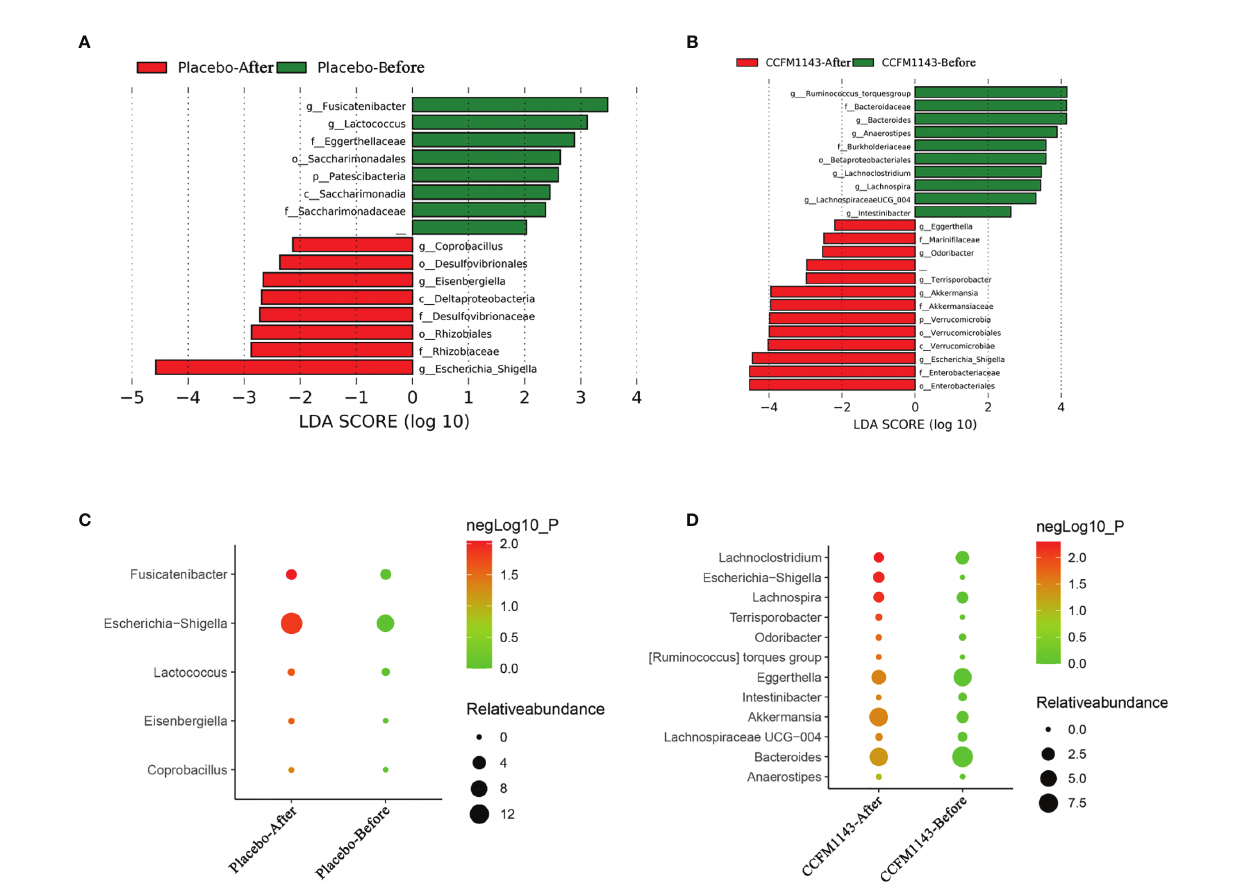
FIGURE 6 | Effect of Lactobacillus plantarum CCFM1143 on the different genera of the gut microbiota in patients with diarrhea. (A) Distribution histogram of the placebo group based on linear discriminant analysis (LDA), with a log LDA score above 2.0. Signi fi cant taxa were labeled and annotated with tags in the right panel . (B) Distribution histogram of the L. plantarum CCFM1143 group based on LDA, with a log LDA score above 2.0. Signi fi cant taxa were labeled and annotated with tags in the right panel . (C) Relative abundance of the different microorganisms in the placebo group. (D) Relative abundance of the different microorganisms in the L. plantarum CCFM1143